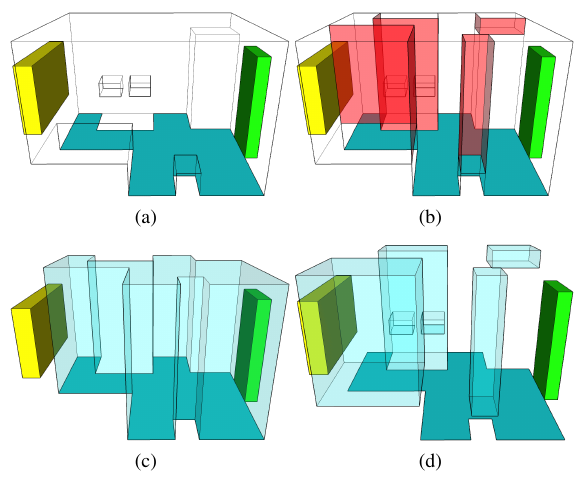
Figure 8. Subdivision based on walk possibility criteria. (a) Walkable surface (dark cyan) in the cell space of 3(d). (b) Cutting faces leading to the targeted sub-spacing. (c) Walkable subspace. (d) Non-walkable